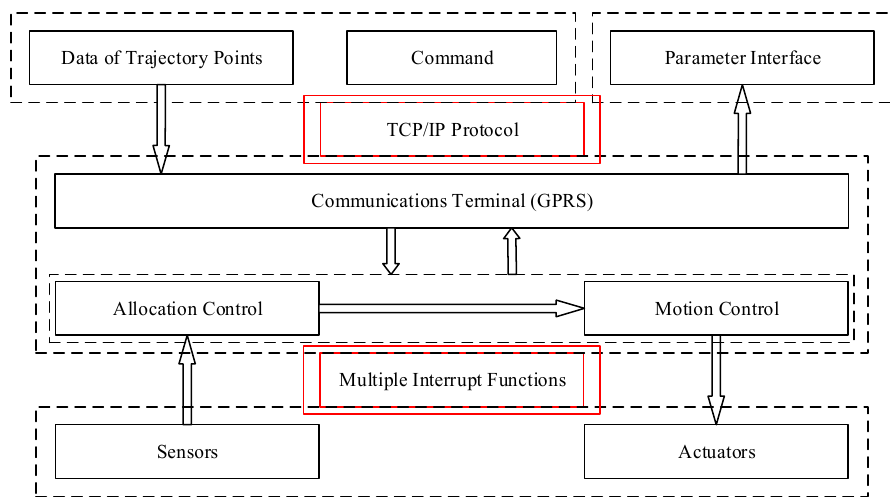
Figure 3. Signal flow.